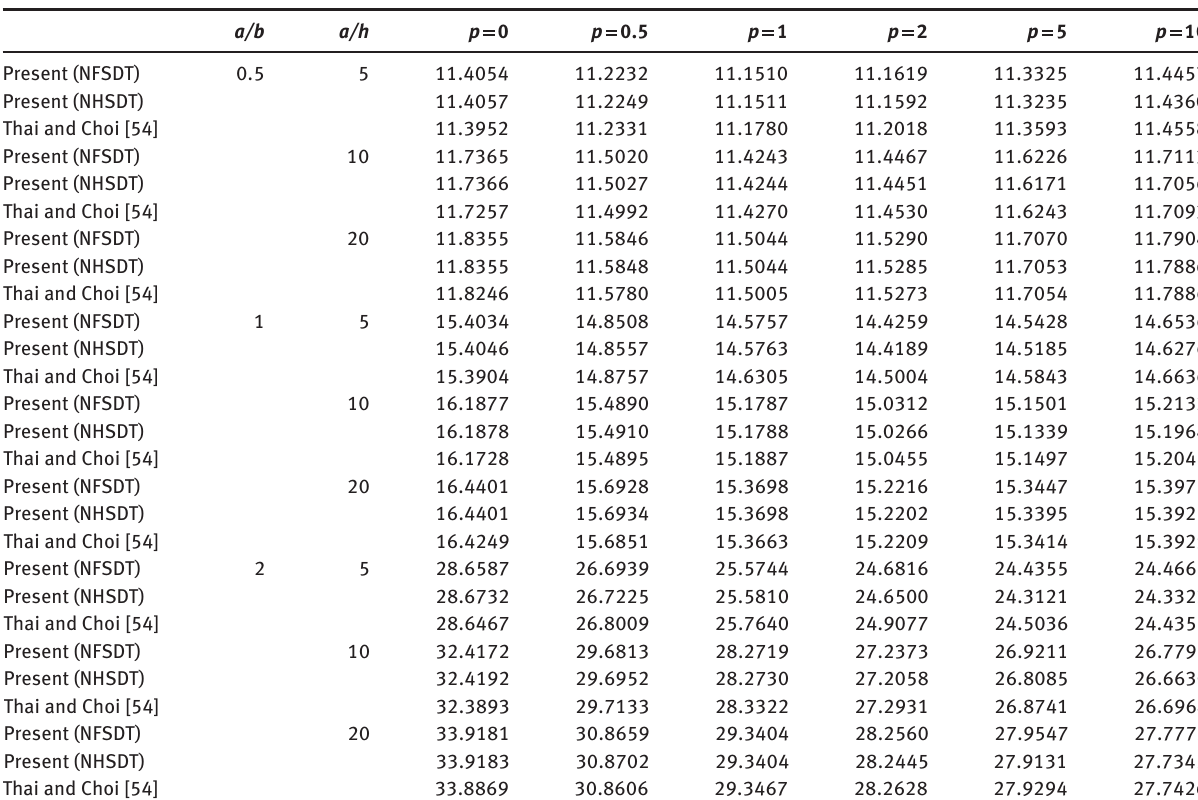
Table 5: Comparison study of the nondimensional fundamental frequency parameter ω = K = 100). foundation ( K w s